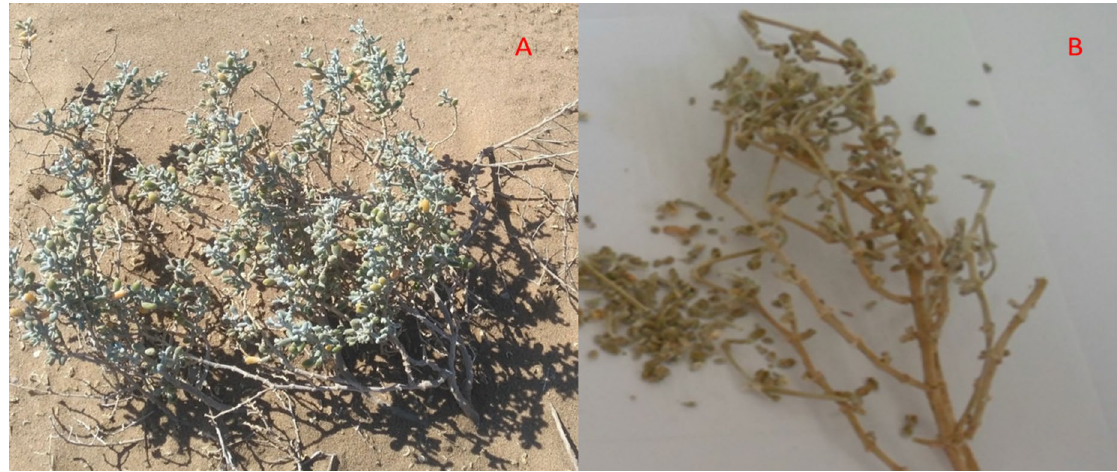
Figure 1. Zygophyllum album plant ( A ) and dried aerial part ( B